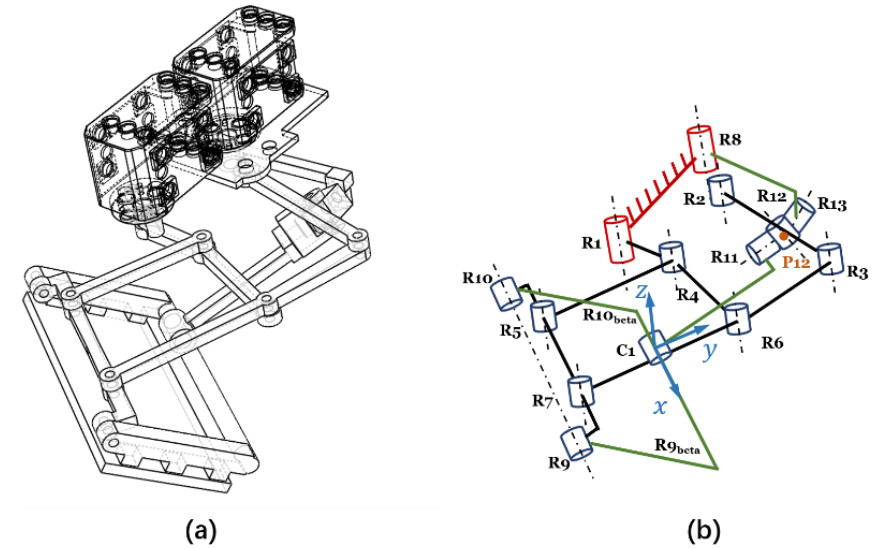
Figure 1. The demonstration of the proposed 2 DoF mechanism.